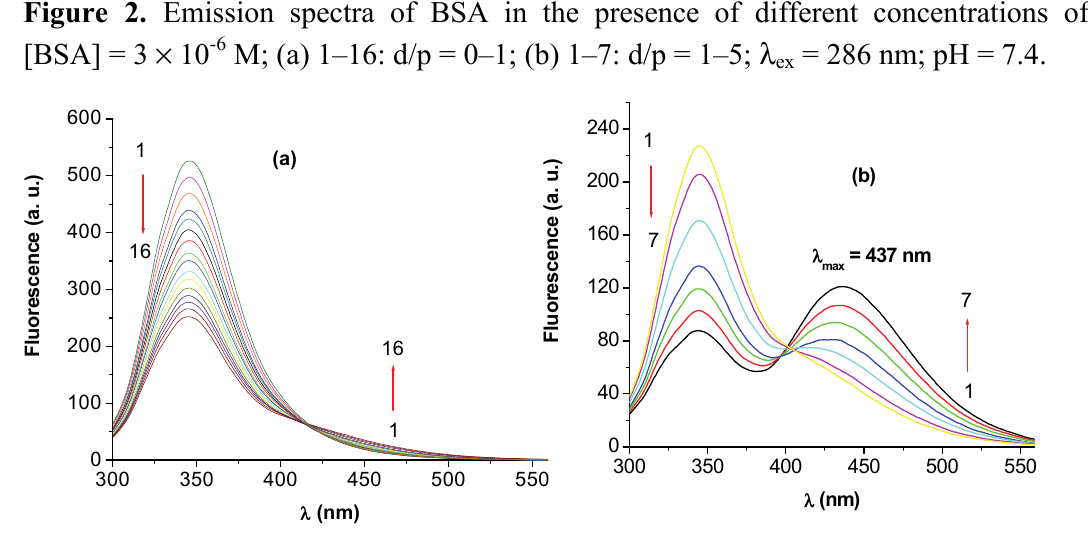
Figure 2. Emission spectra of BSA in the presence of different concentrations of I